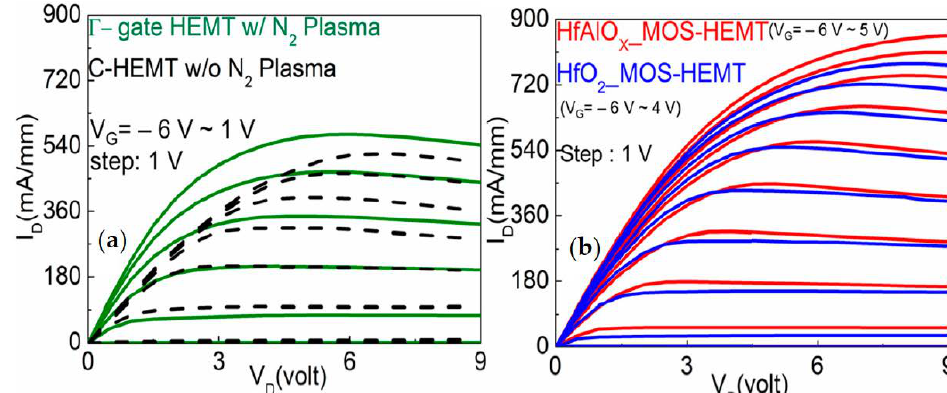
Figure 4. Comparison of drain current-voltage (I D –V D ) characteristics of ( a ) Γ -gate HEMT (with the N 2 plasma treatment) and non-recessed HEMT (w/o the N 2 plasma treatment) and ( b ) Γ -gate HfO 2 and HfAlO X MOS-HEMT with the N 2 plasma